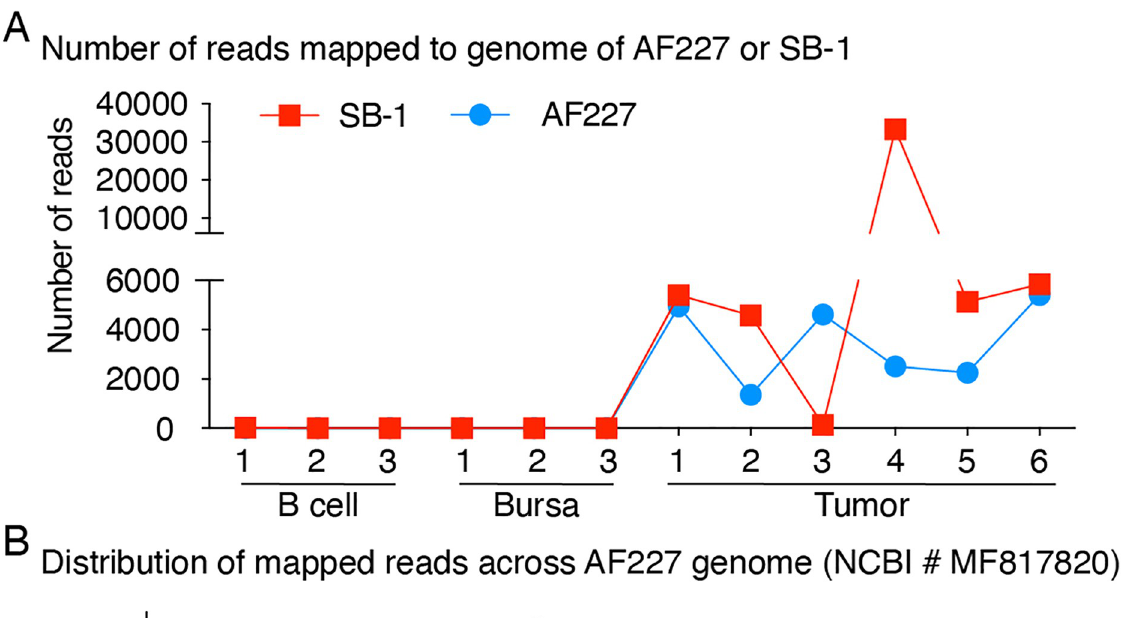
PLOS ONE | https://doi.org/10.1371/journal.pone.0272557 August 8,